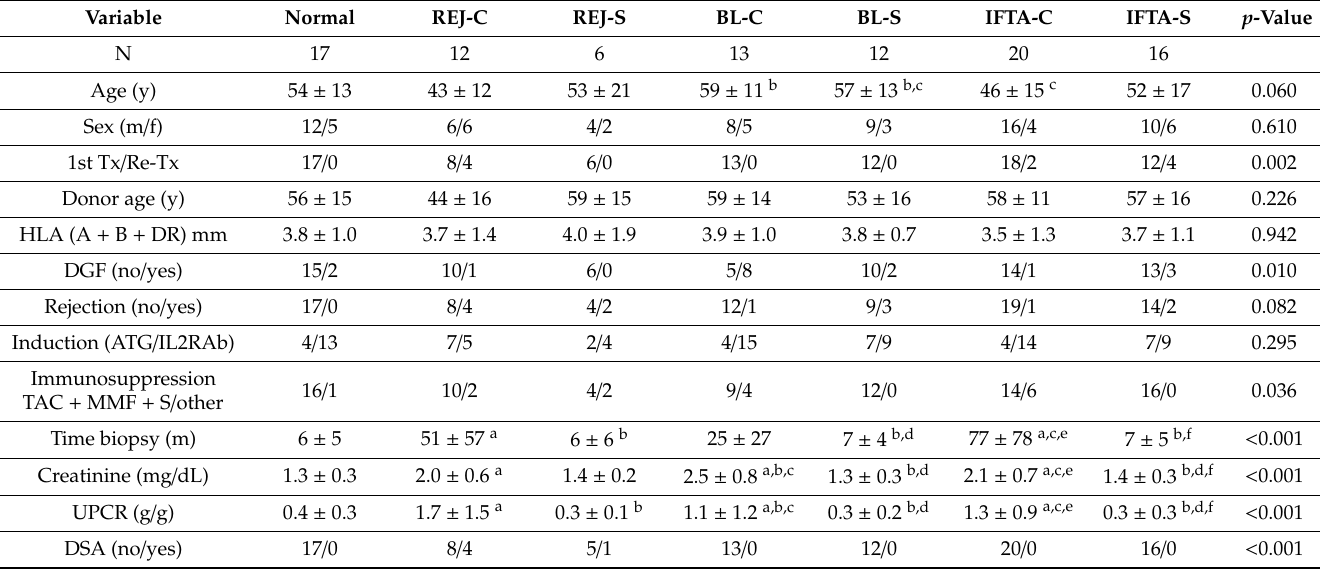
Table 2. Demographic data for recipients and donors as well as clinical data at the time of